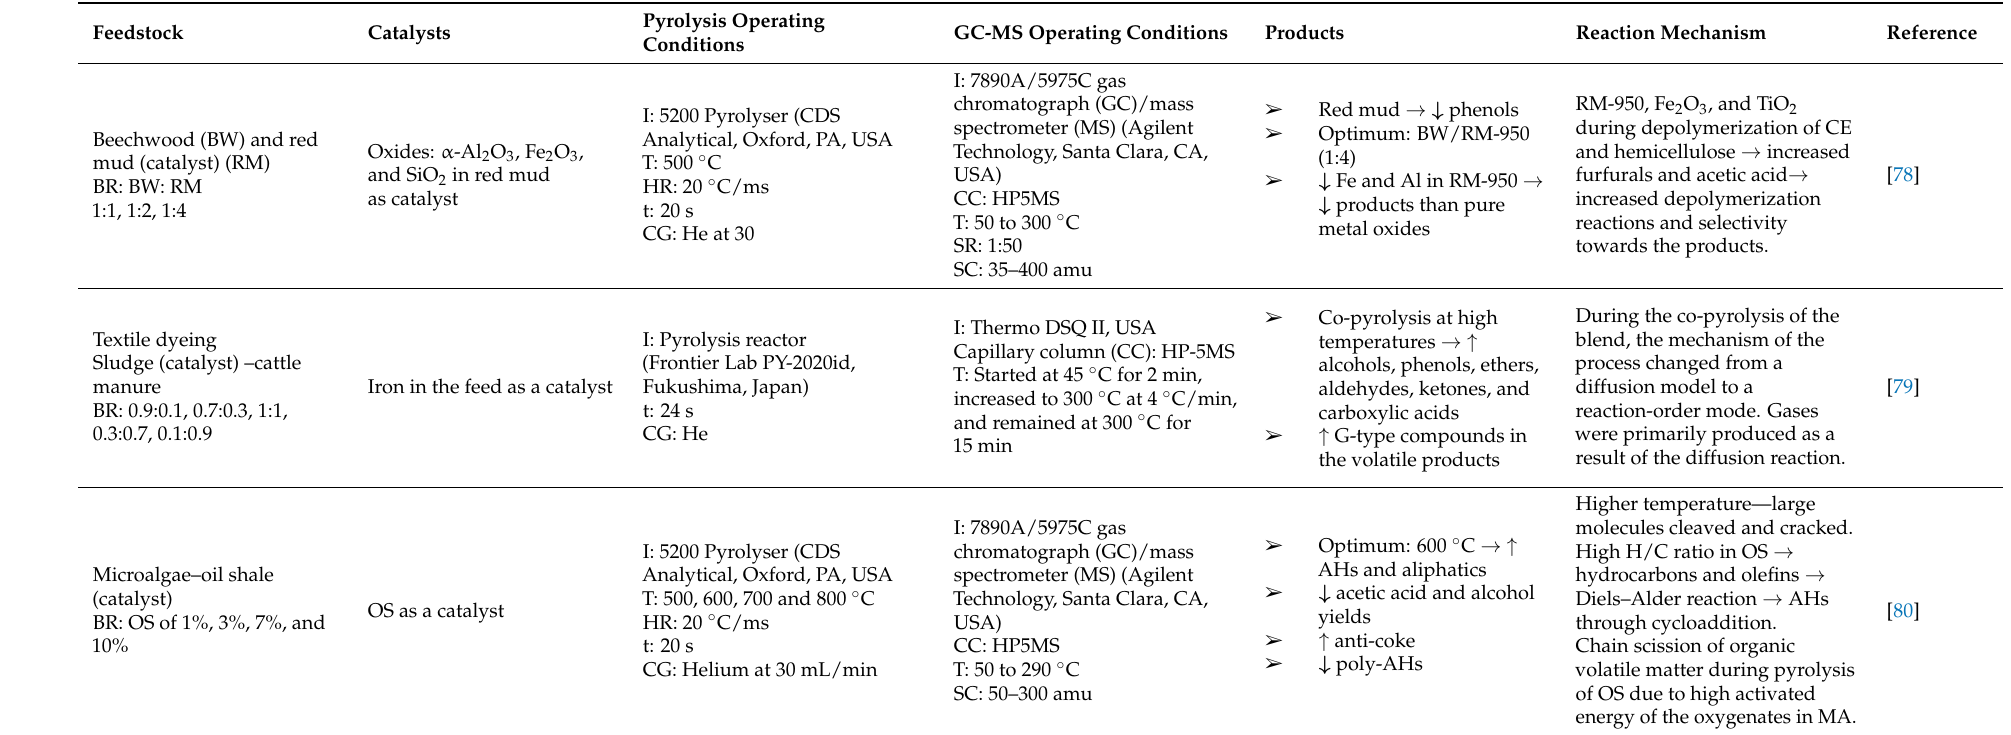
Table 3. Findings of catalysts other than zeolites from selected articles reviewed in this